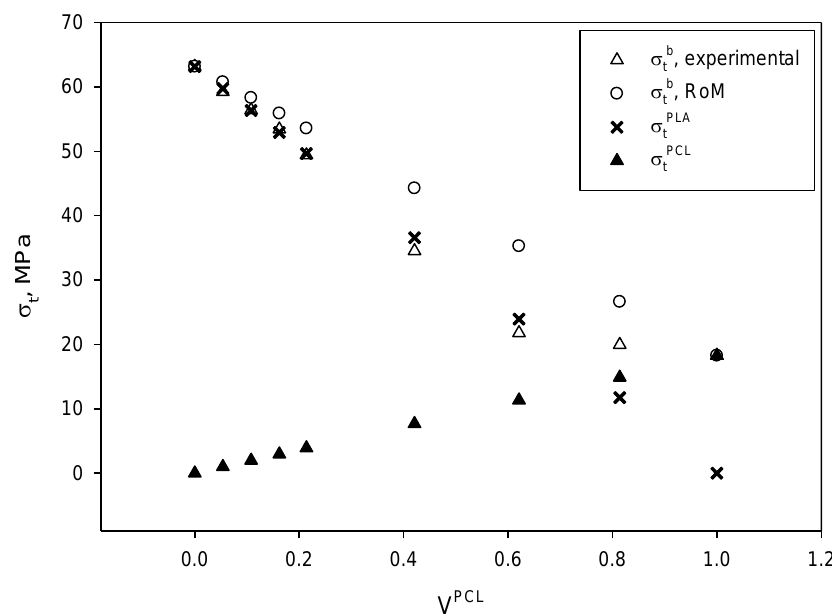
Figure 4. Evolution of tensile strength of PLA/PCL blends as PCL fraction was increased, both experimental and results from the rule of mixtures (RoM) and contributions of each constituent.